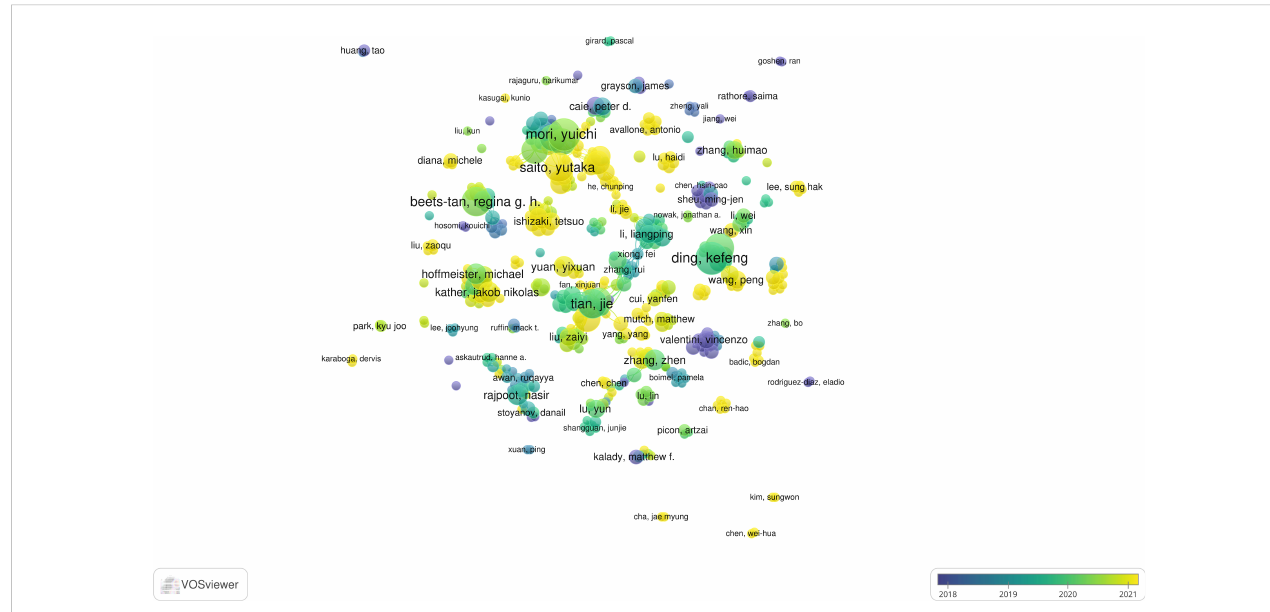
FIGURE 3 Visualization of co-authorship through VOSviewer (Circles represent the number of articles published. Connecting lines represent collaboration between authors. Colors represent the average year of authors ’